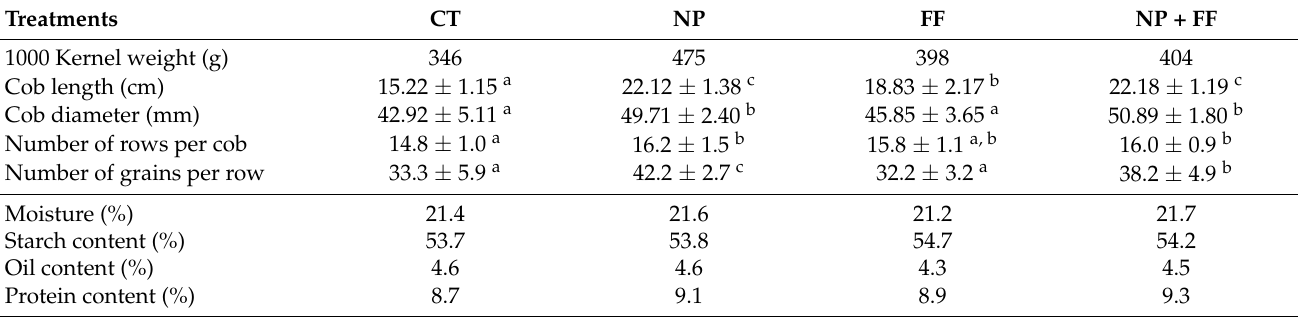
Table 3. Parameters of maize yield. Data represent mean ± SD (n = 10); Chl: chlorophyll; Car: carotenoids; CT: untreated control; NP: nitrapyrin; FF: foliar fertilizer; NP + FF: joint treatment of nitrapyrin and foliar fertilizer, FW: fresh weight. Different lowercase letters denote significant differences (one-way ANOVA and Duncan’s multiple range test, p ≤ 0.05) between the different